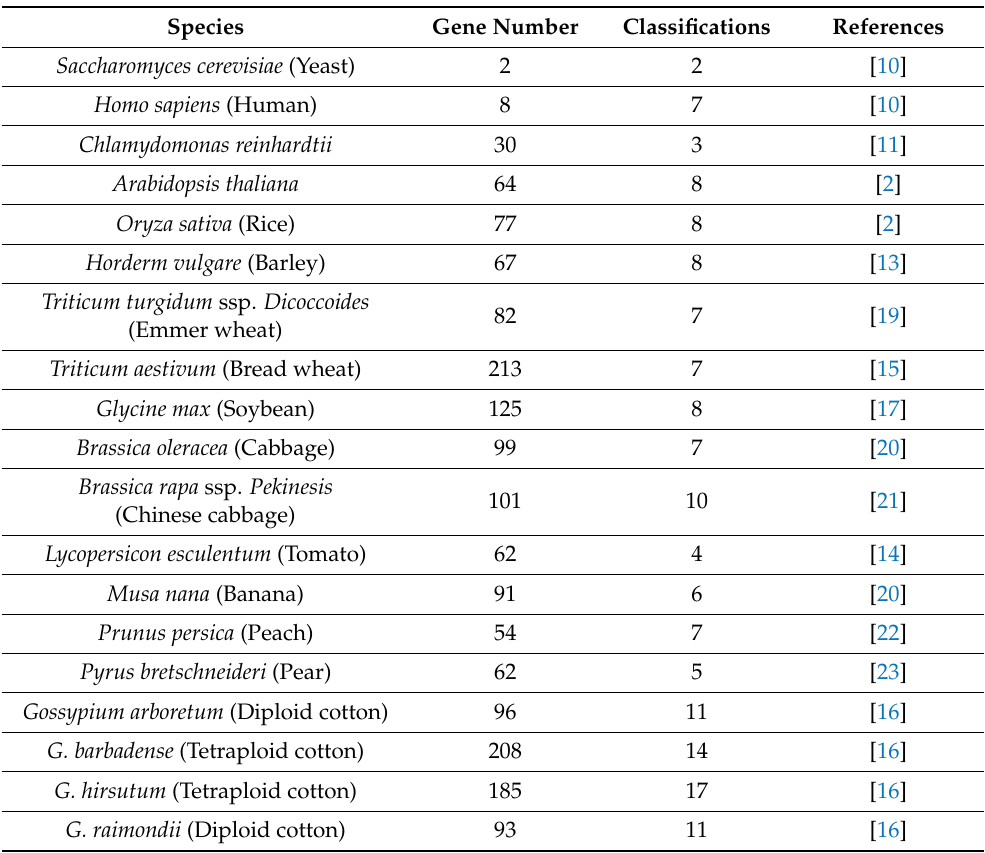
Table 1. Comparisons of gene number and classifications of the U-box E3 ubiquitin ligases in various species. Species Gene